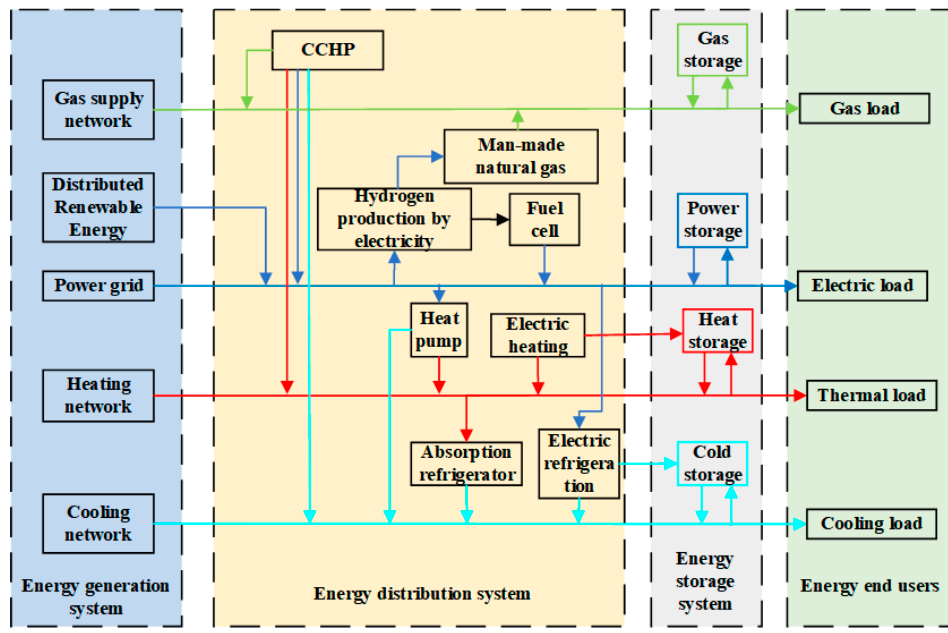
Figure 1. Typical system structure of a microgrid.